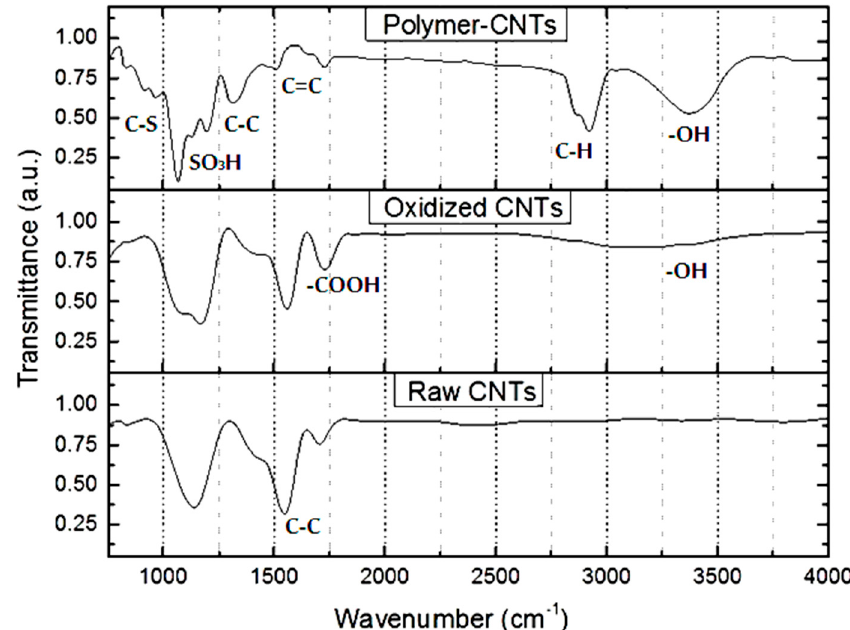
Figure 2. Fourier-transform infrared FTIR spectra of the raw, oxidized and polymer functionalized carbon nanotubes.